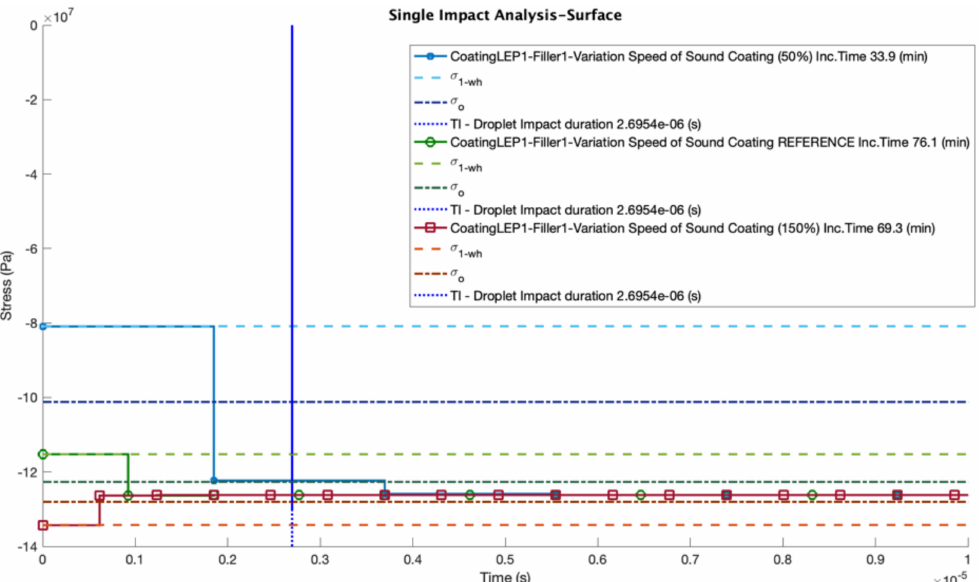
Figure 10. Surface stress evolution analysis for simulated material LEP prototype comparing 50% variation of LEP coating Speed of Sound.